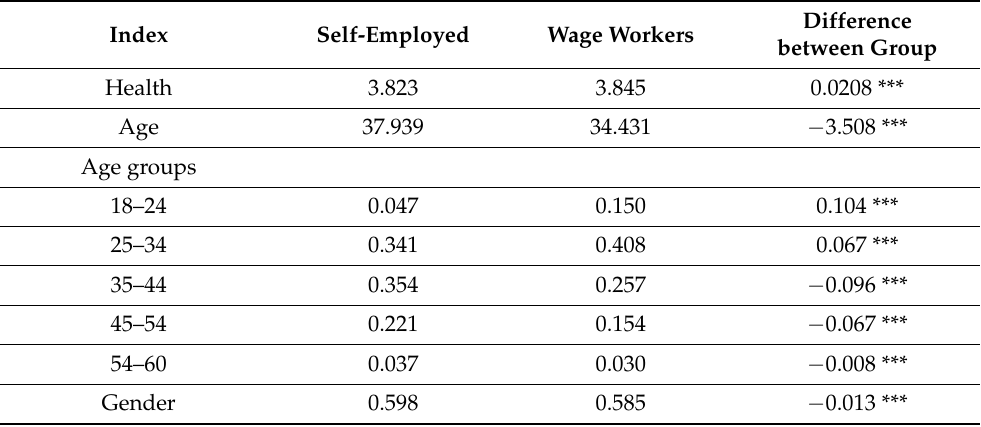
Table 2. Descriptive